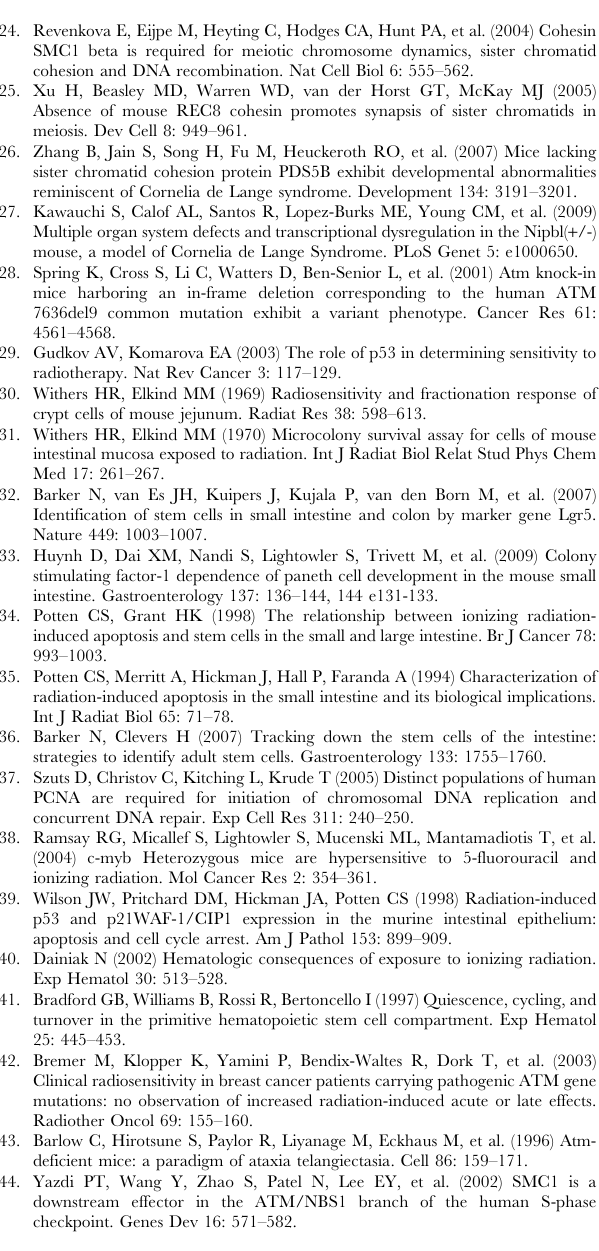
Figure S5 Immunostaining of RAD21 protein in mouse intestinal crypts. DNA was counterstained with DAPI. Focus numbers in Rad21 + / 2 cells are approximately 30 to 50 fold the number seen basally in these cells. Left panels: black and white micrographs showing c H2AX foci. Right panels: merged images of c H2AX foci (red) and DAPI (blue). Scale bars = 20 m m. Found at: doi:10.1371/journal.pone.0012112.s005 (3.72 MB